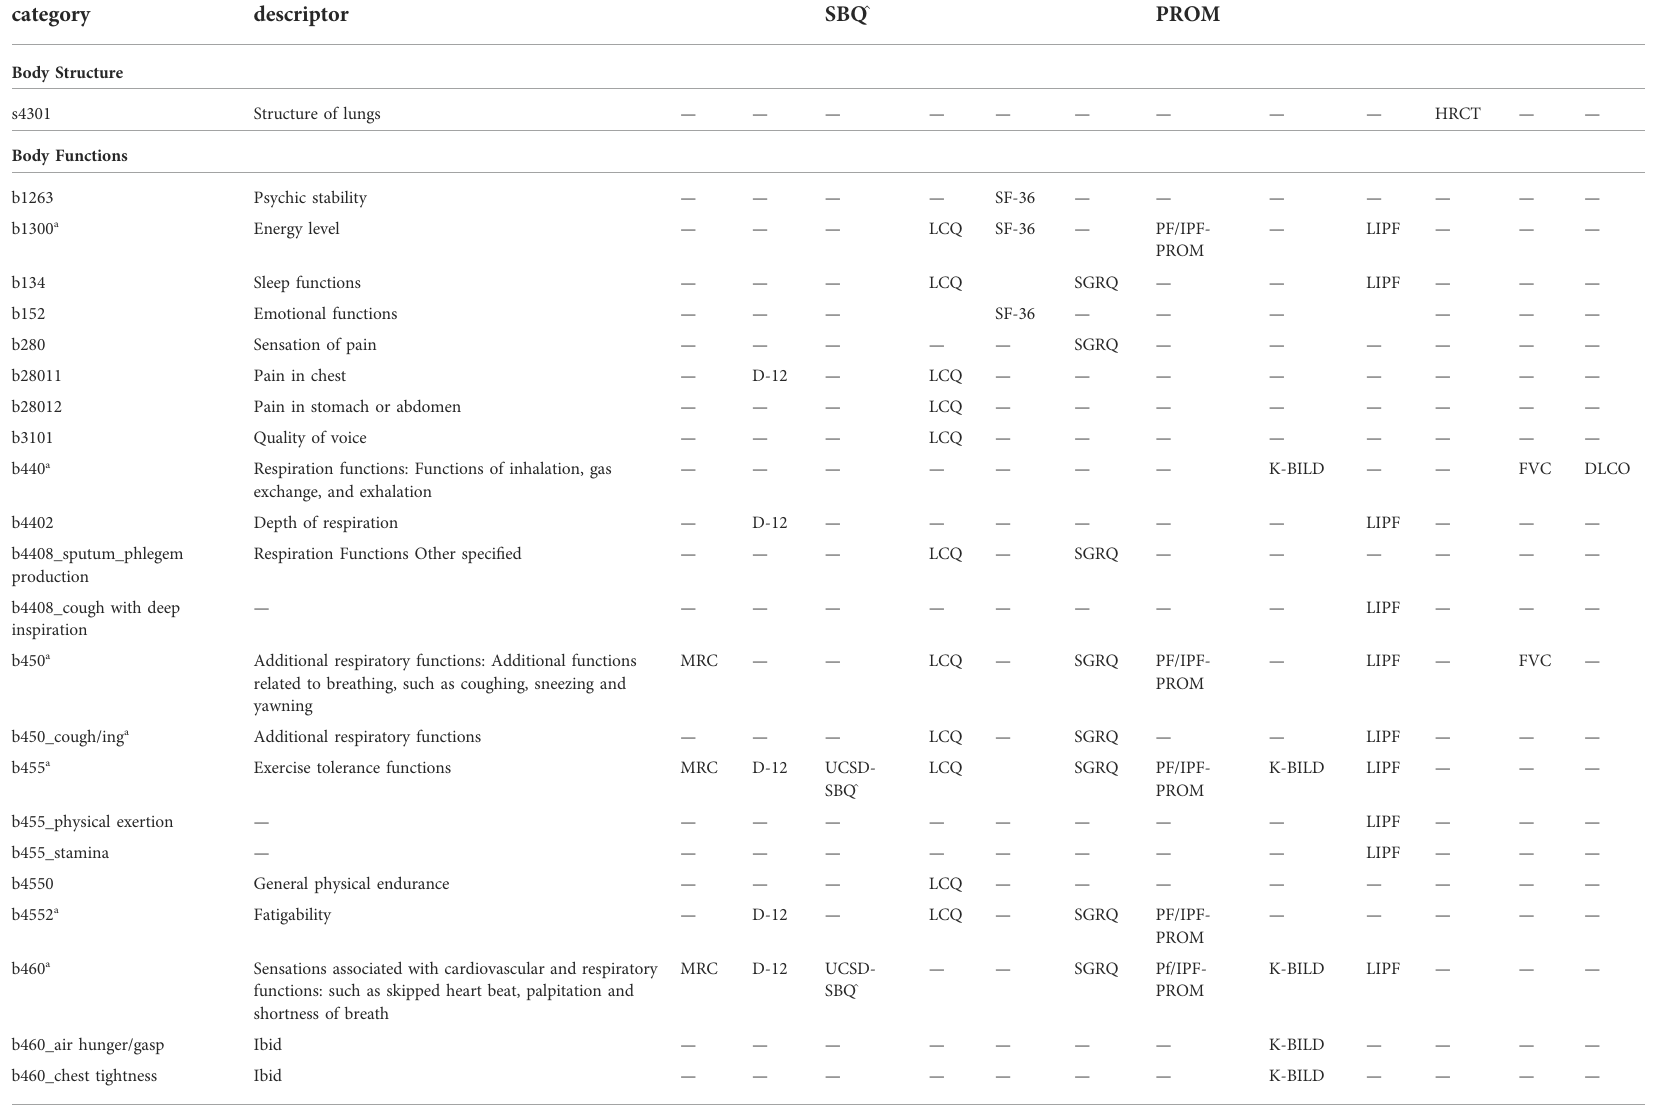
TABLE 4 Categories according to instrument ( Courtesy of LA Saketkoo, with permission, rights reserved ) WHO ICF